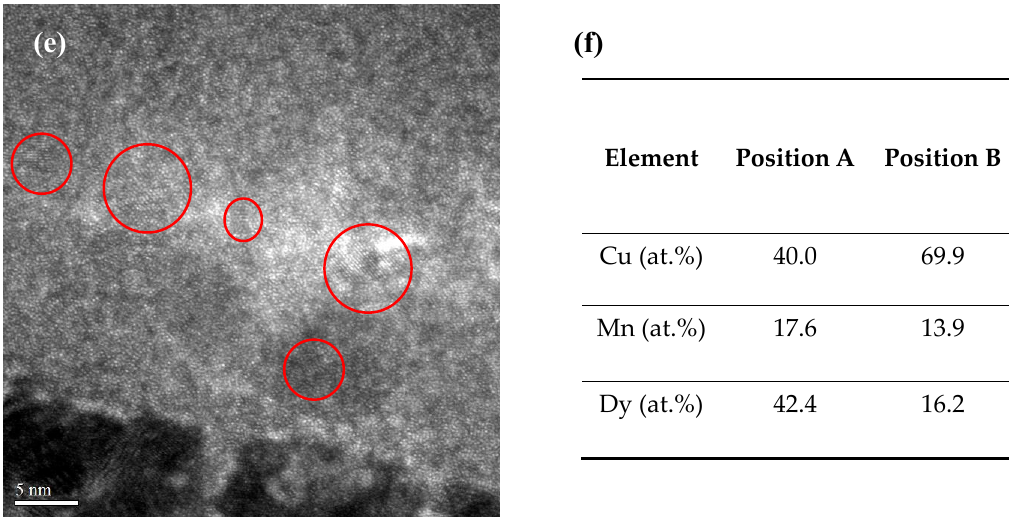
Figure 4. TEM micrographs of Cu–Mn films with 40 at.% Dy addition annealed at 350 ◦ C: ( a ) bright field of cross-section, ( b ) HRTEM micrographs at position B, ( c ) selected-area electron diffraction of position B, ( d ) selected-area electron diffraction of position A, ( e ) HRTEM micrographs at position A, ( f ) EDX analysis.